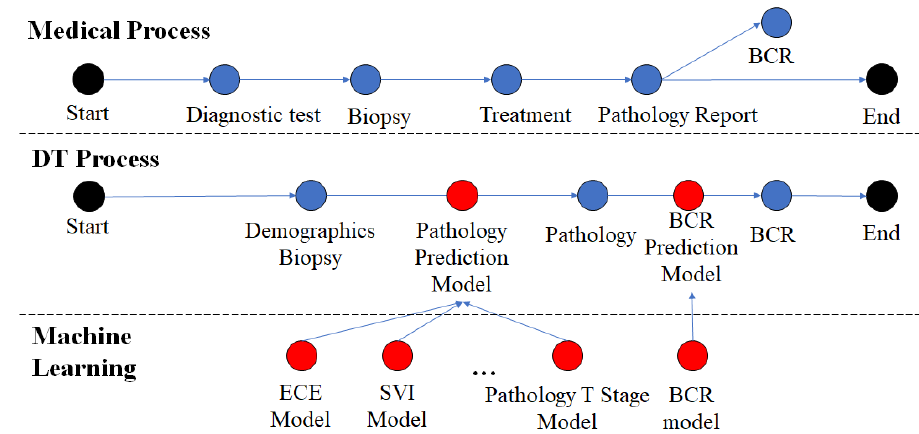
Figure 3. PCa and DT process (digital twin: DT; ECE; seminal vesicle: SVI; perineural invasion: biochemical recurrence: BCR).